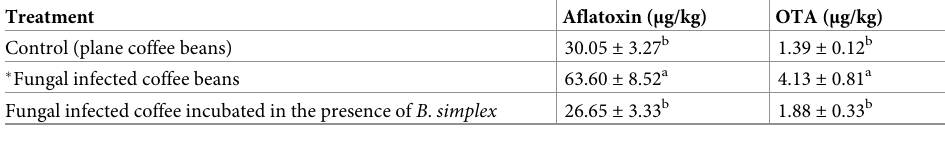
Table 2. Effect of bacterial volatiles on the inhibition of mycotoxins synthesis by toxigenic fungi on coffee beans.